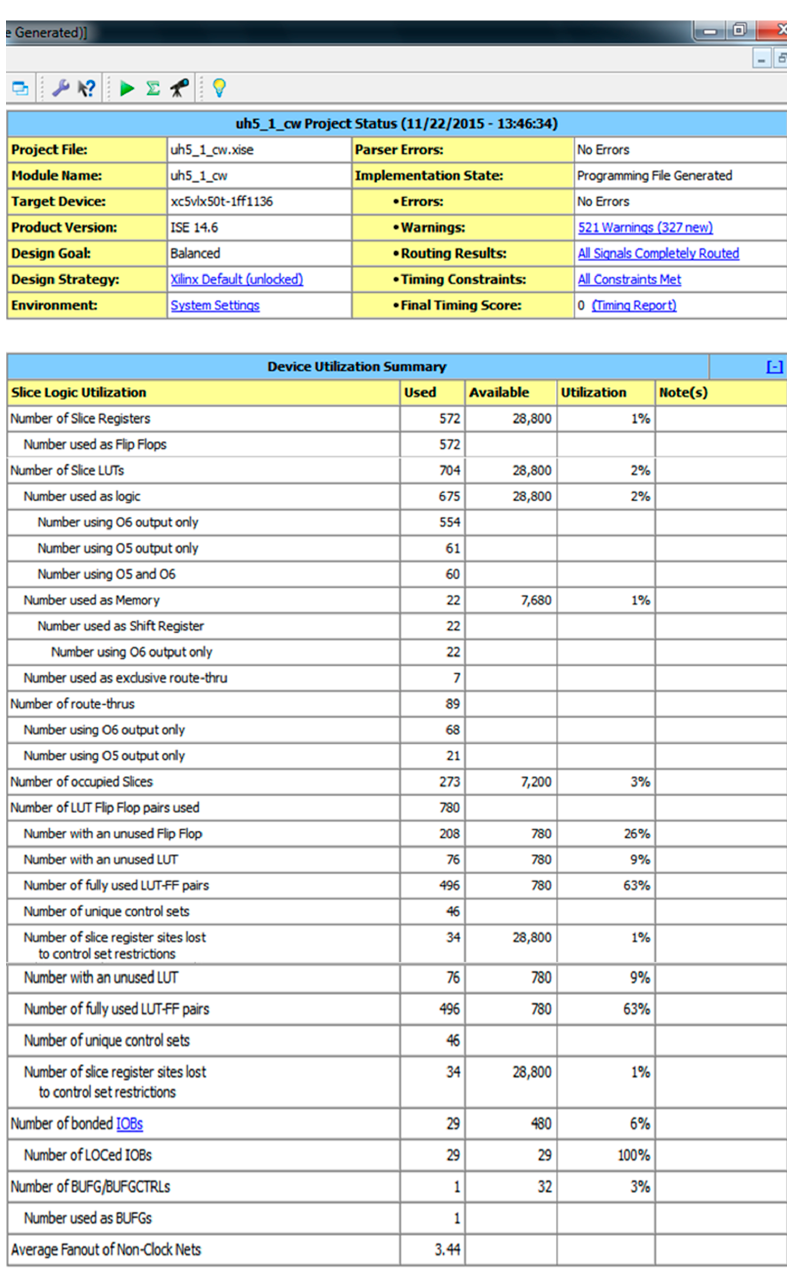
Figure 14. Summary report presenting FPGA devices’ utilization.